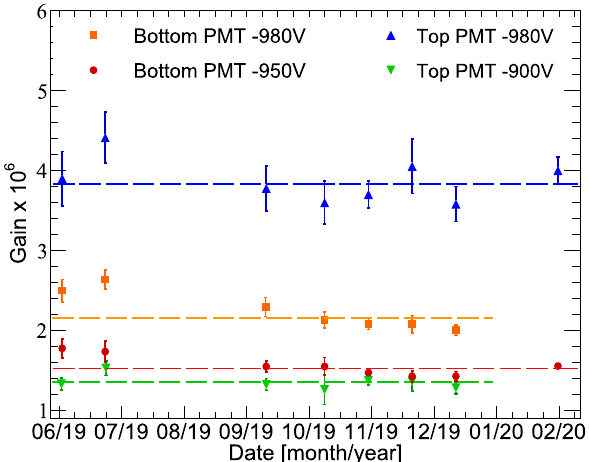
Fig. 10 Stability of the top and bottom PMT gains for two different HV configurations. The dashed lines are constant fits to the data